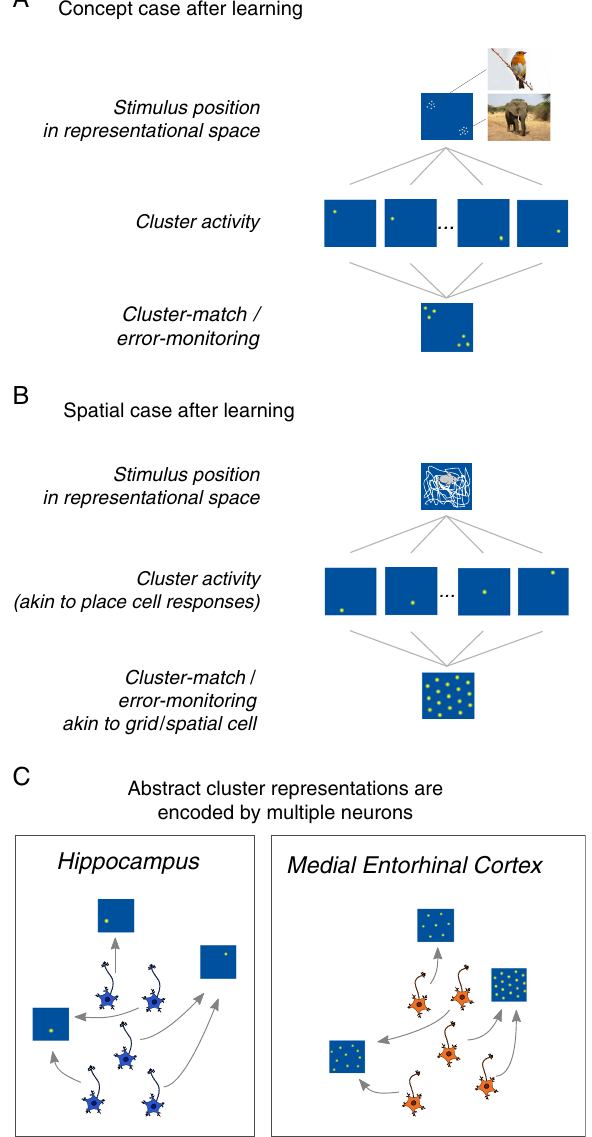
Fig. 2 Cluster representations after learning for conceptual and spatial